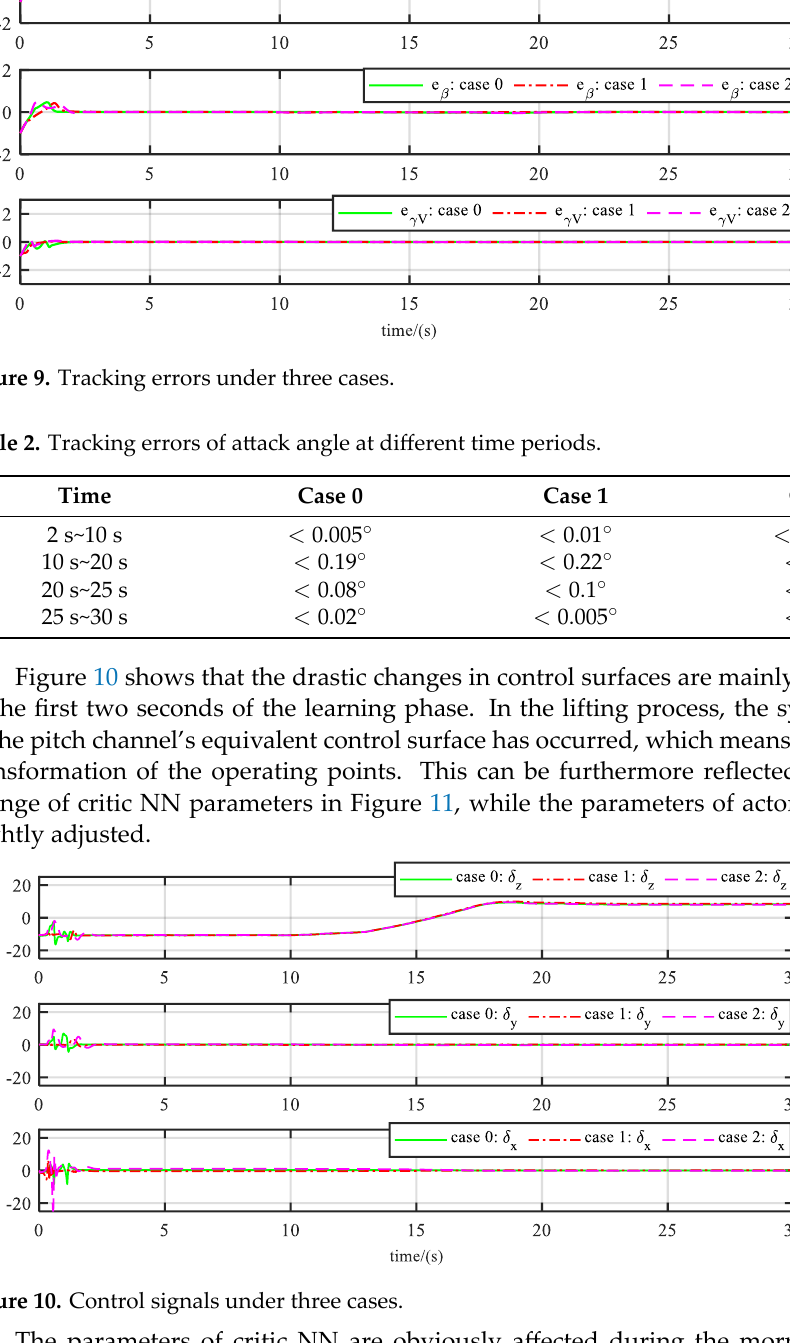
Figure 10. Control signals under three cases.